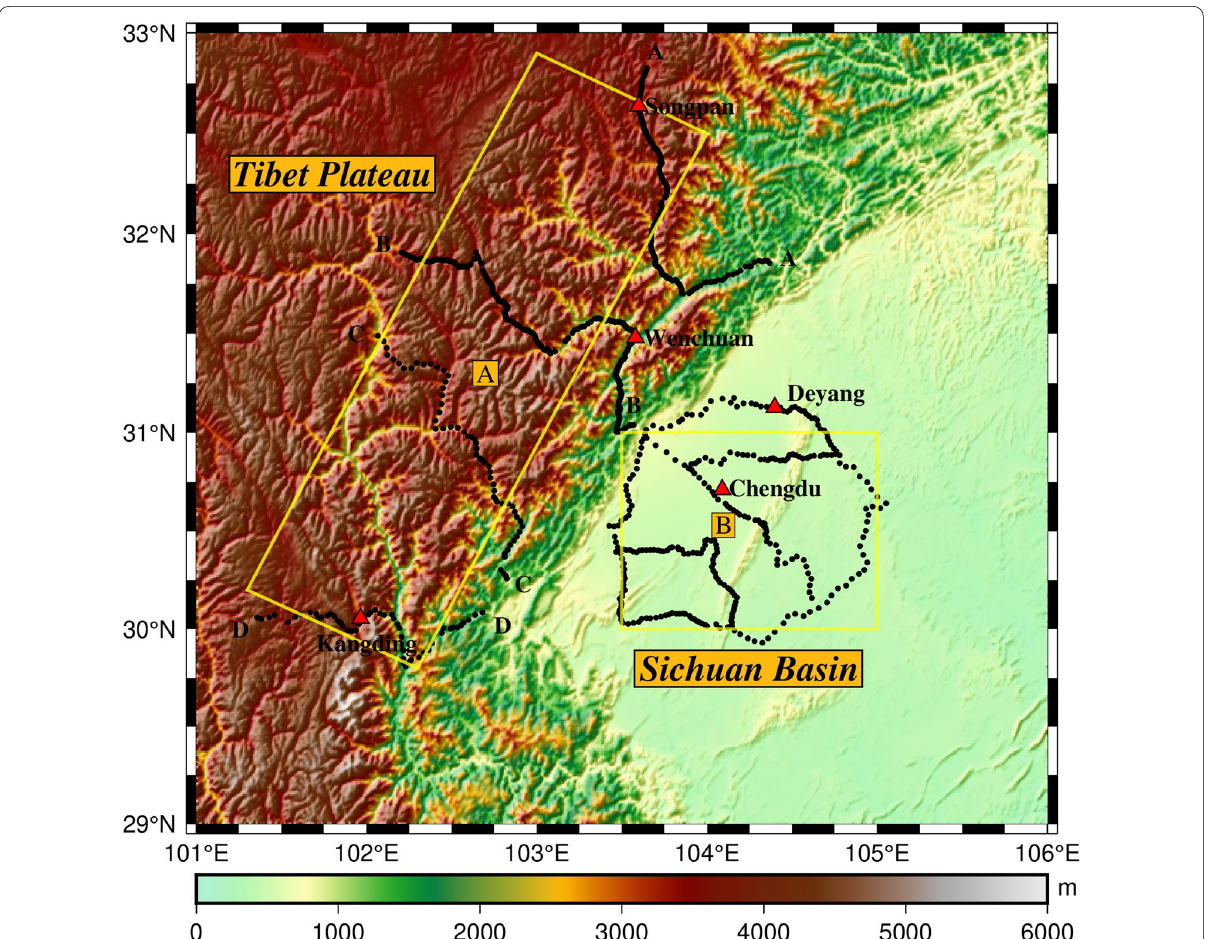
Fig. 1 Study area and gravity datasets distribution. Black points represent the positions of the gravity observations, and the yellow rectangles show the locations of the two subregions of the study area